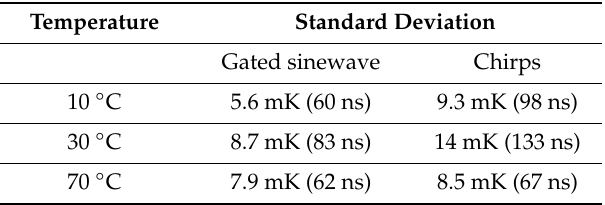
Table 2. Standard deviation of temperature measurements of chirps and single frequency tone at di ff erent temperatures. The standard deviations of measured time delays are shown in the